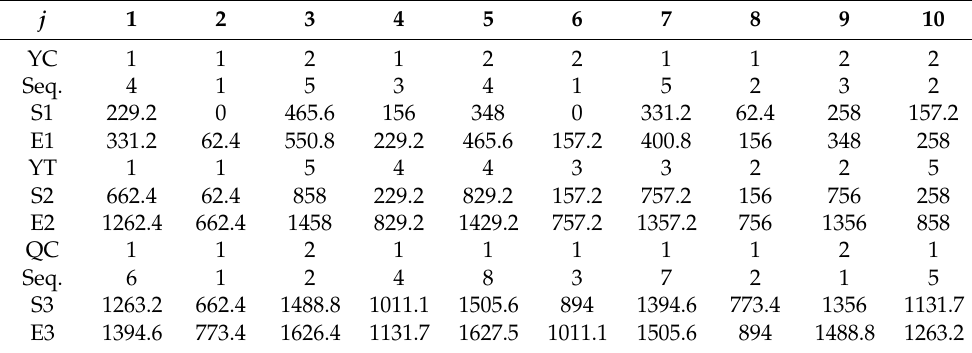
Table 7. The solutions to the integrated problem of YCSP, YTSP, and QCSP found by Method4 (MGPSO).